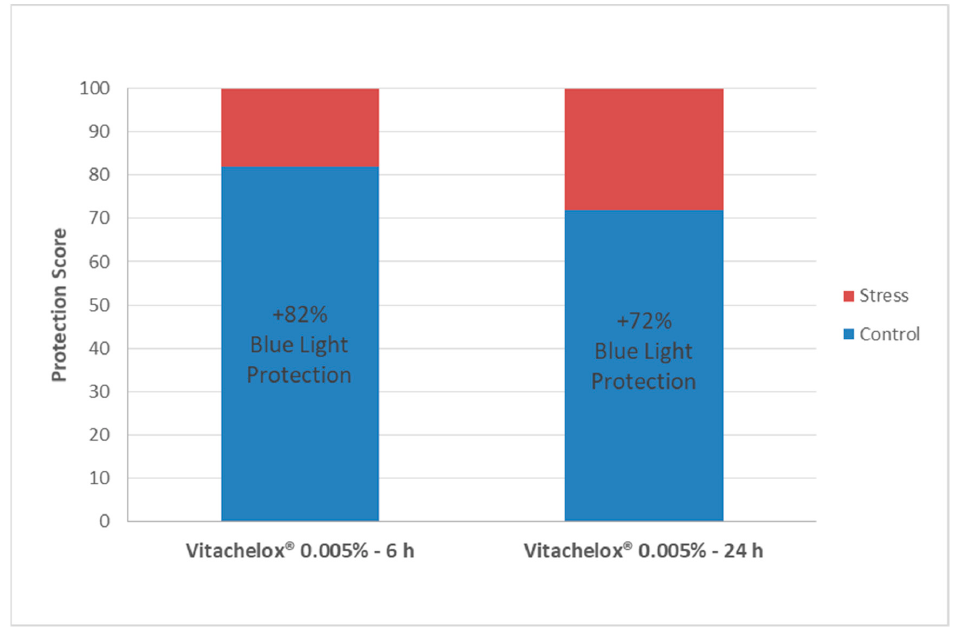
Figure 5. Protection Score. The values (%) represent the performance of Vitachelox® to effectively contrast the deleterious effects of blue light irradiation at a molecular level. Control refers to the not irradiated cells, while stress corresponds to cells irradiated with no protective agent.